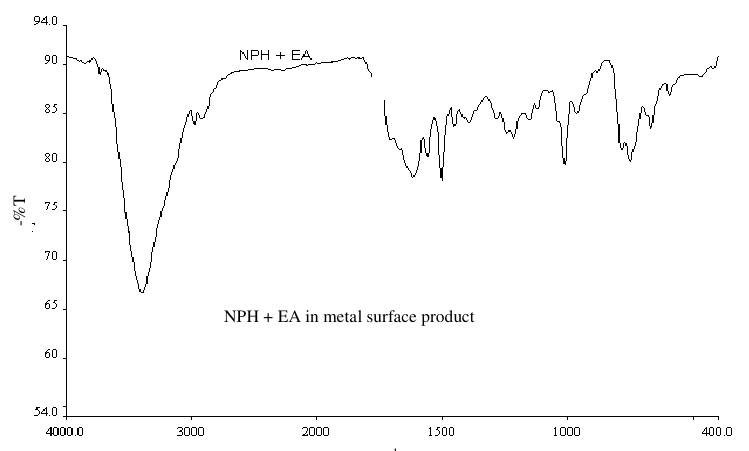
Figure 7. FTIR spectra of metal surface after immersion in the acid solution containing the binary mixture of NPH and EA